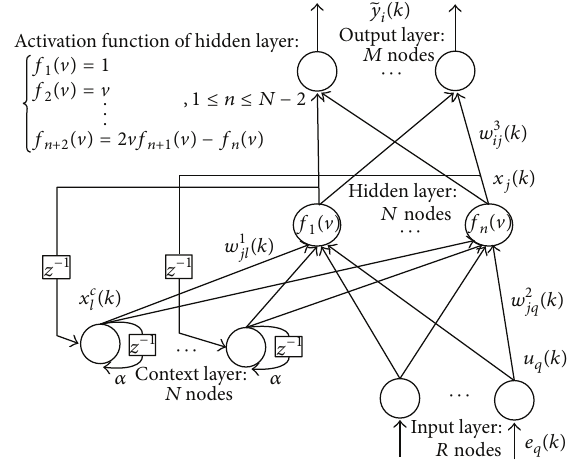
Figure 2: The architecture of